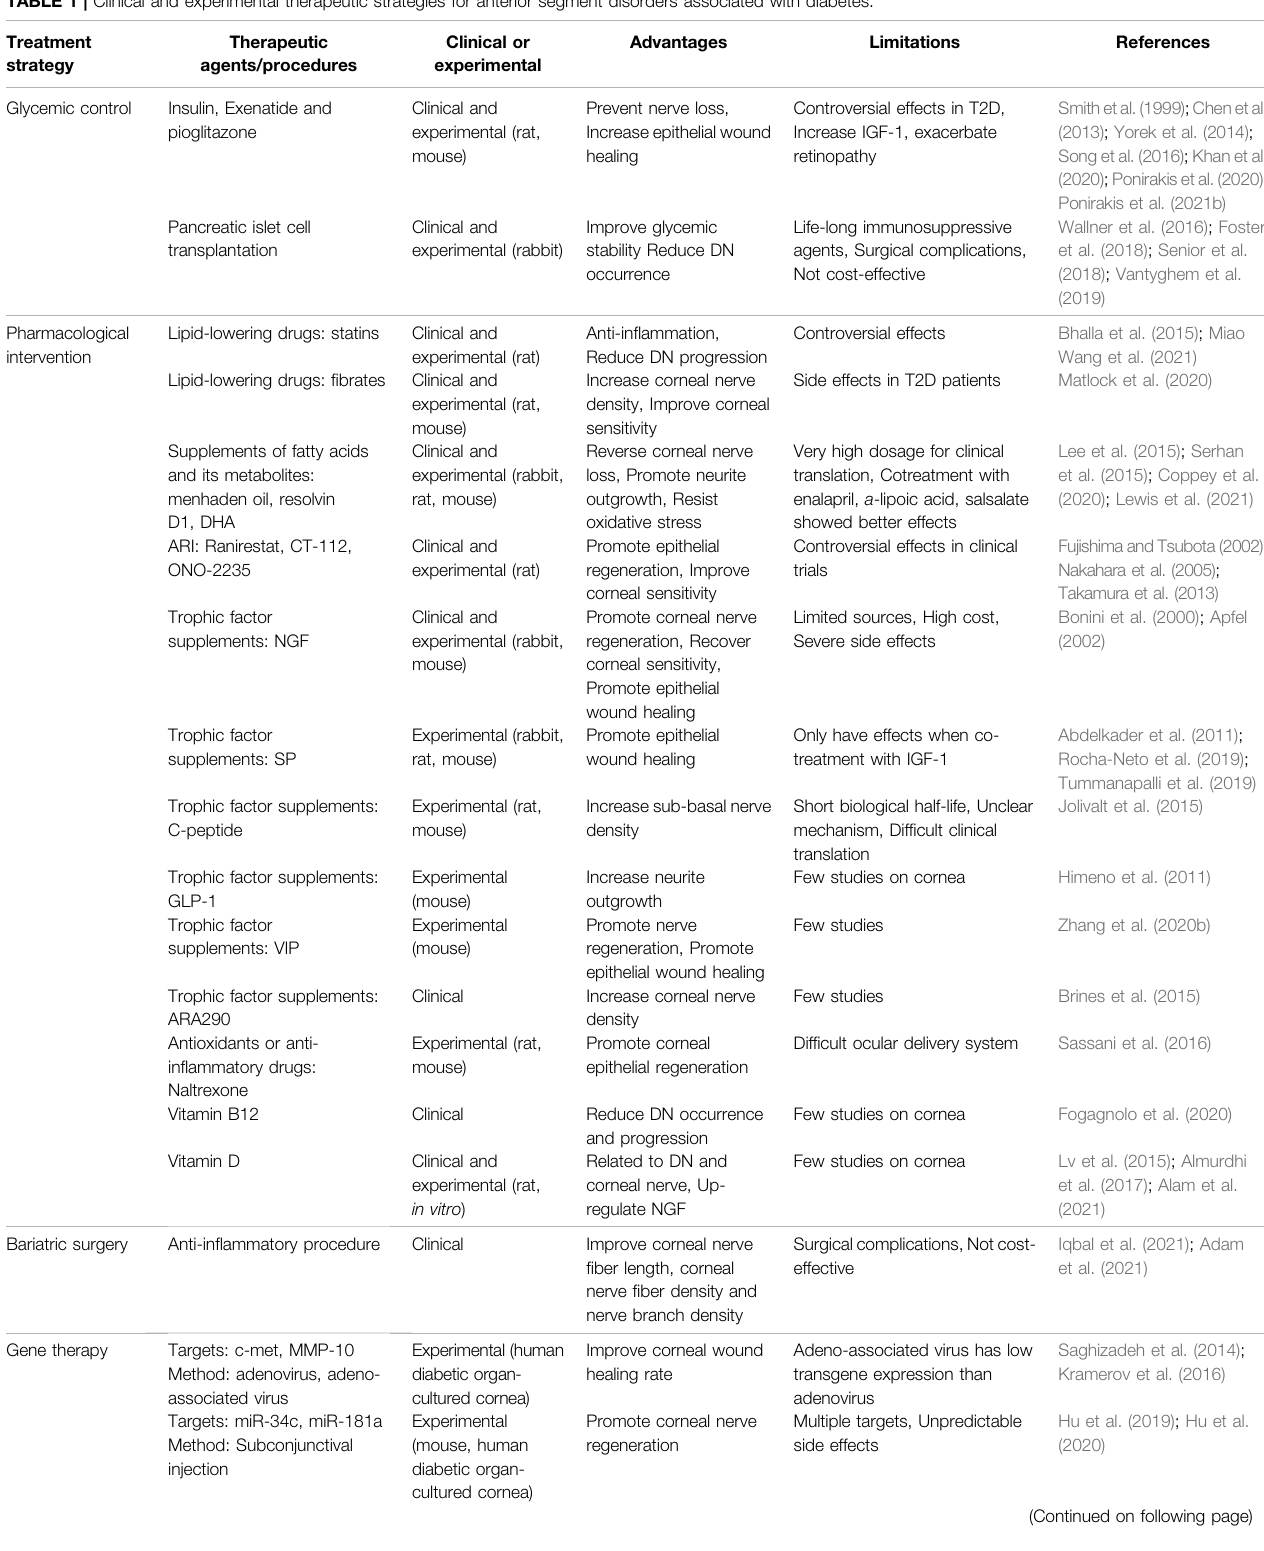
TABLE 1 | Clinical and experimental therapeutic strategies for anterior segment disorders associated with